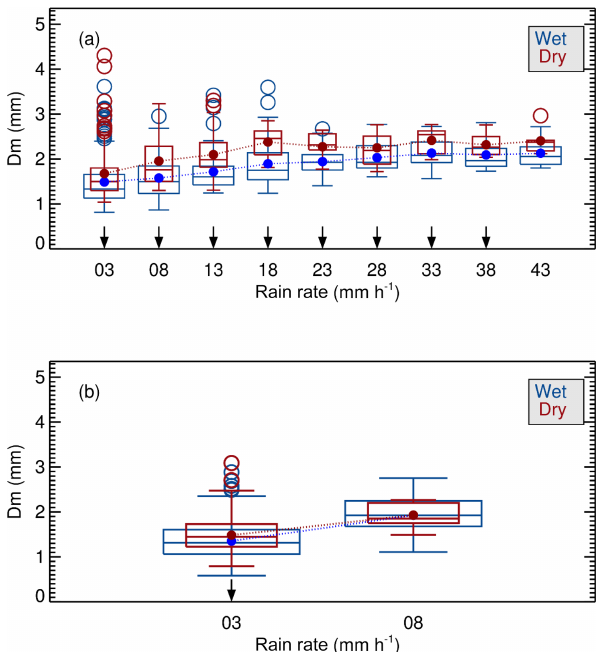
Figure 4. Mass-weighted mean raindrop diameter ( D m ) as a func- tion of the rainfall rate (RR) for wet and dry seasons for (a) convec- tive and (b) stratiform rain events. The arrows on the x axis indicate variations in the averages based on the Student’s t test (95% confi- dence). The box represents the 25 to 75% populations and the line inside the box shows the median value; the circles are the